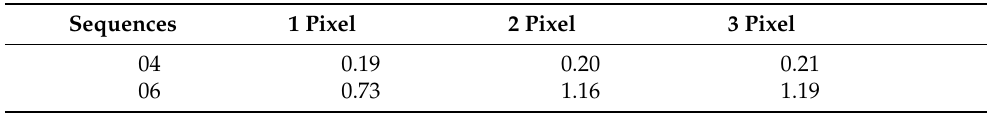
Table 4. Comparison of different pixel thresholds for calculating the distances to the epipolar lines when calculating the essential